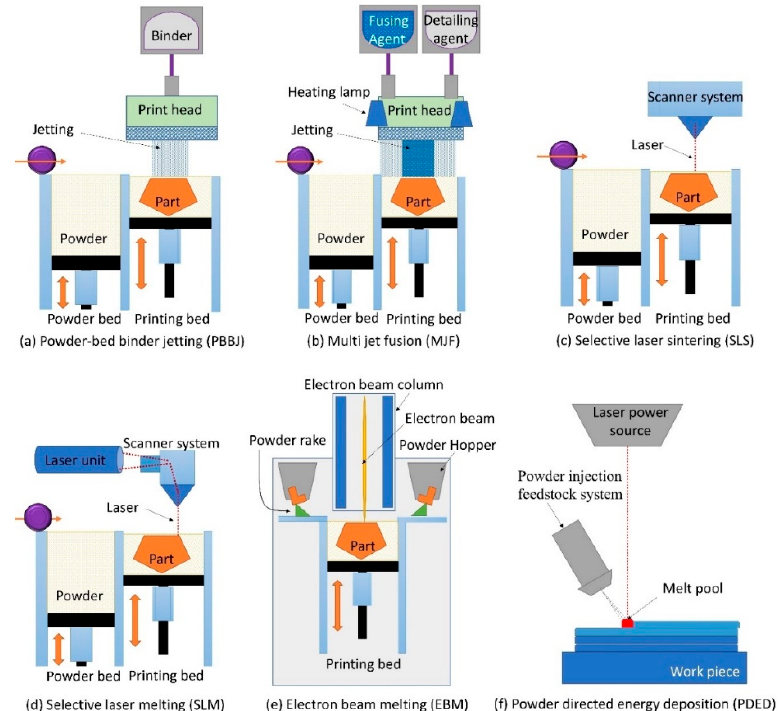
Figure 2. Schematic diagram of the various powder-based 3D-printing processes. ( a ) Powder bed binder jetting (PBBJ): jetting of chemical binder; ( b ) multi jet fusion (MJF): jetting of fusing and detailing agent. Infrared heat absorbing polymer fusion method; ( c ) selective laser sintering (SLS): laser powered sintering method; ( d ) selective laser melting (SLM): laser powered localized material melting method, ( e ) electron beam melting (EBM): electron beam powered localized metal melting method; ( f ) powder directed energy deposition (PDED) or direct laser metal deposition (DLMD): laser powered injected-material melting method.